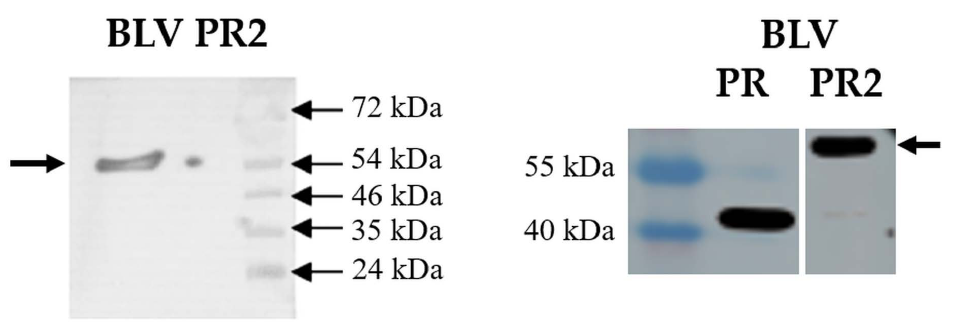
Figure 4. Autoproteolysis of BLV PR2. The Western blot was performed by using anti-BLV (left panel) and anti-MBP antibody (right panel). Arrows indicate the full-length MBP-fused proteins, self-proteolysis was detected only in case of the wild-type